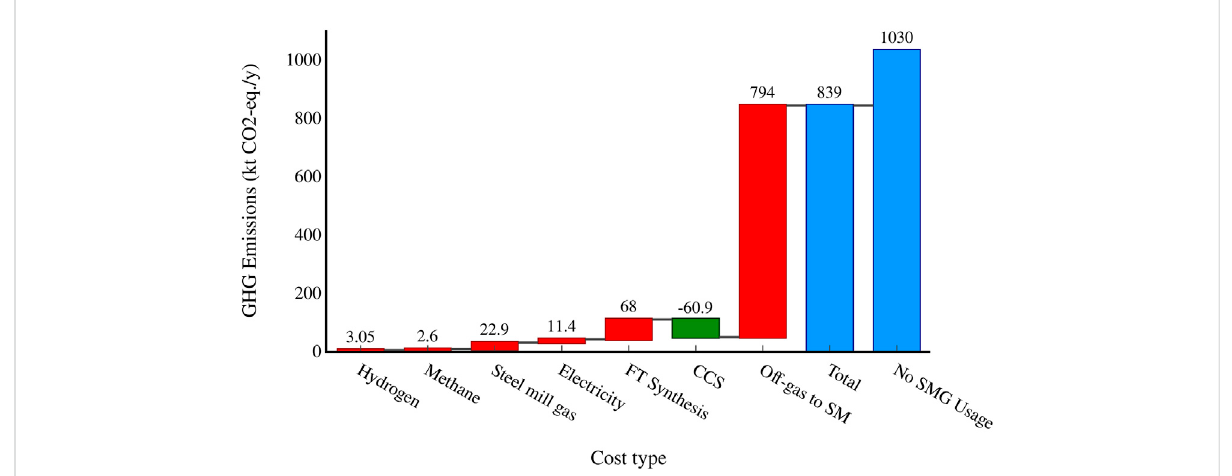
FIGURE 11 Waterfall graph showing the yearly emissions from different process segments and the total yearly process emissions compared to the yearly emissions if the steel mill ran as normal. A capture rate of 90% is assumed.